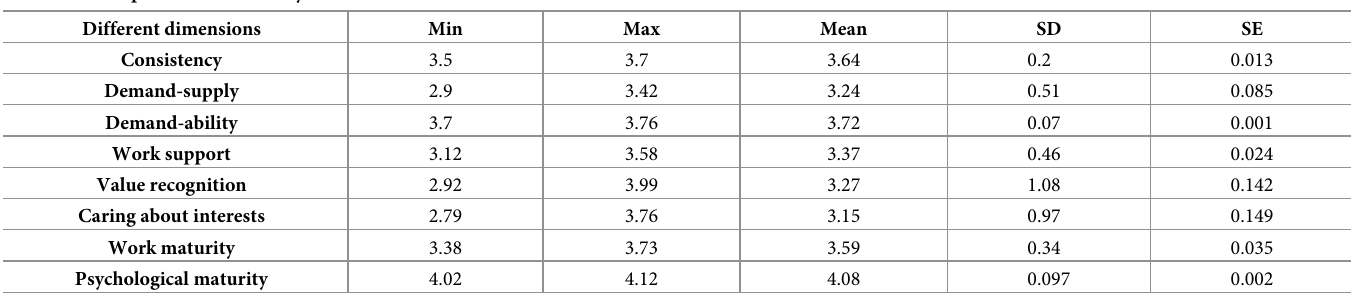
Table 2. Descriptive statistical analysis results of each variable. Different dimensions